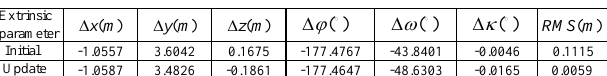
Table 3. Extrinsic parameters and accuracy of Laser scanner